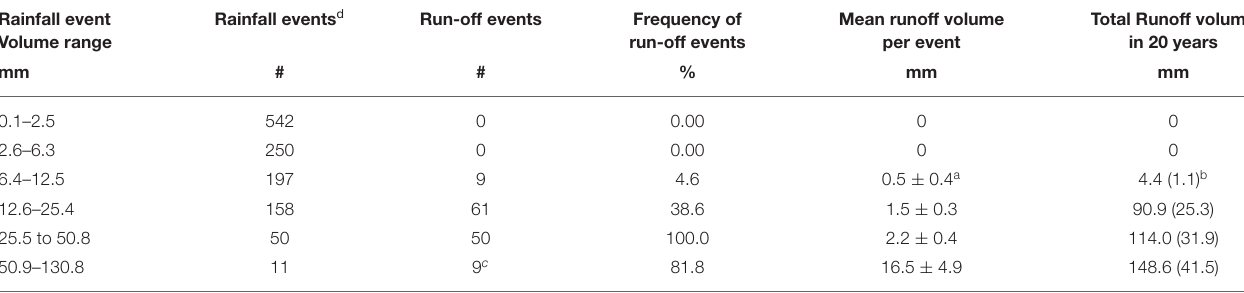
TABLE 2 | Rainfall events by volume categories, and the frequency and volume of runoff from cropped graded terraces. Rainfall event Volume range